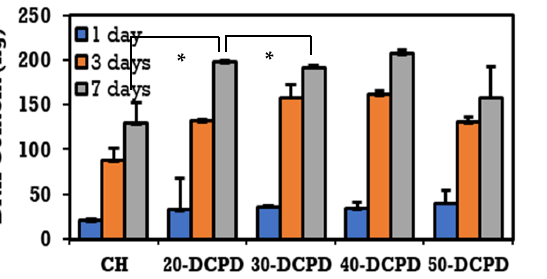
Figure 6. Extract cytotoxicity and proliferation testing using osteoblast cell line G292 cells on freeze- dried scaffolds. Positive and negative controls consisted of steri-strips and McCoy’s media with 40% DMSO. ( A ) Extract cytotoxicity results where testing consisted of 5000 cells/well G292 osteoblast cells, measured as the percentage of extracts collected after 1, 3 and 7 days. ( B ) 5-day cell proliferation percentage live extract cytotoxicity results where testing consisted of 500 cells/well G292 osteoblast cells. ( C ) Contact cytotoxicity testing of Giemsa-stained cell line G292 osteoblast cells for unloaded and DCPD mineral-loaded freeze-dried chitosan scaffolds (objective × 20). Images were collected digitally using the Leica CTR HS microscope under bright field illumination. All samples were compared to negative (steri-strips) and positive (40% dimethyl sulfoxide (DMSO)) controls. ( D ) Fluorescence microscopy images of cell line G292 osteoblast cells adhered to scaffold surfaces. After 48 h of cell seeding, samples were fixed and processed using Alexa Fluor-488 phalloidin to label actin (green) and Dapi to label nucleic acids in the nuclei (blue) (objective × 10). ( E ) Cell proliferation of undoped and mineral-doped freeze-dried scaffold evaluated using PicoGreen assay. The error bars are equivalent to the mean ± standard deviation (SD) ( n = 3 in each group). The * refers to statistical significance when p <